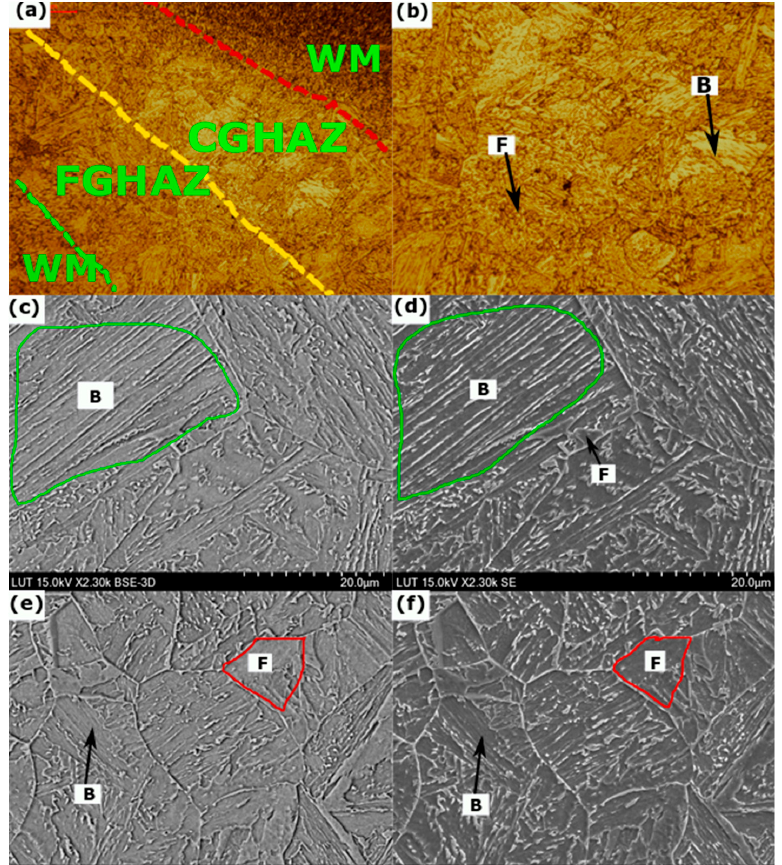
Figure 8. Optical microscopy ( OM) and SEM micrographs showing the microstructures of S700MC steel in different sub-zones of the welded joint: ( a ) description of different sub-zones of the welded joint, ( b ) OM image of the coarse-grain heat-affected zone (CGHAZ) of S700MC, ( c – d ) SEM image of CGHAZ, and ( e – f ) SEM image of fine-grain heat-affected zone